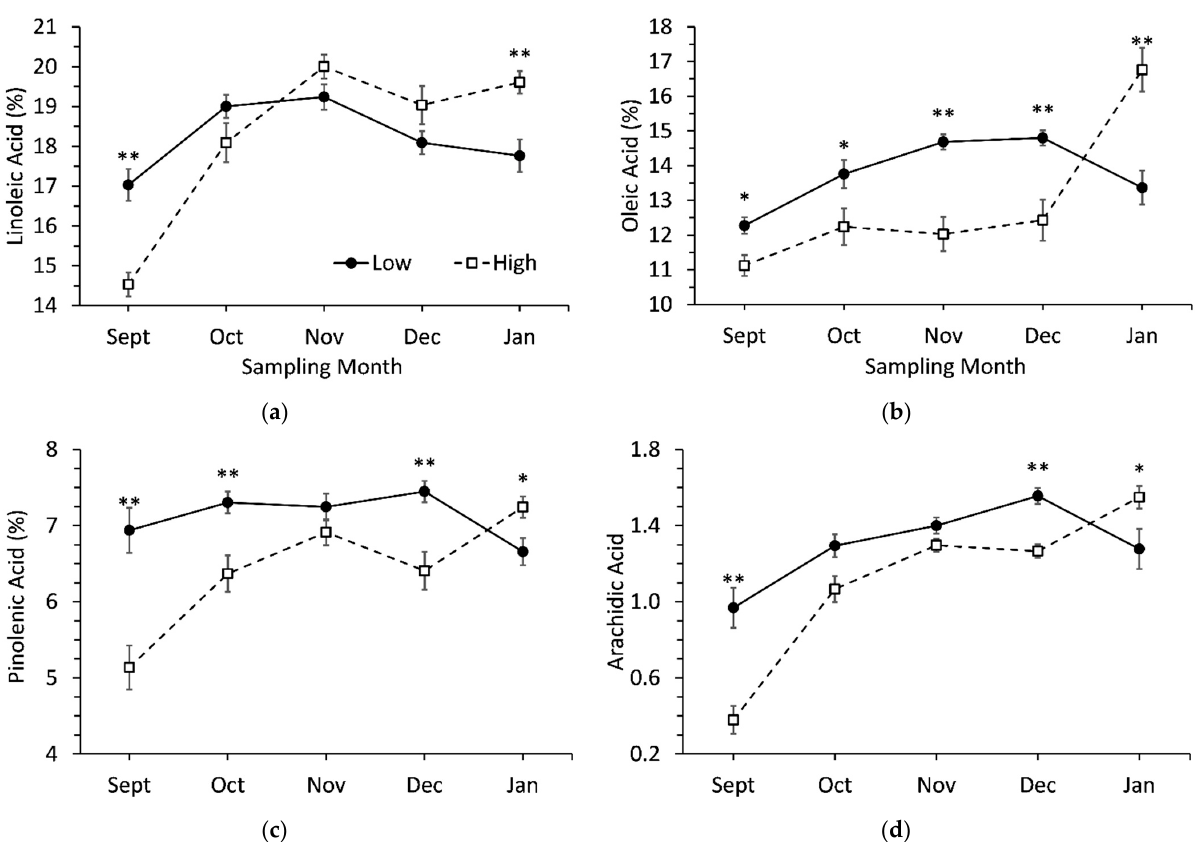
Figure 5. Interactive effects between balsam fir genotype (low and high needle abscission resistance) and sample collection date for ( a ) linoleic acid, ( b ) oleic acid, ( c ) pinolenic acid, and ( d ) and arachidic acid. Each data point represents a mean ± standard error as calculated from of 10 branches. The * indicated 1% to 5% significance and the ** indicates less than 1% significance between genotypes at any month.